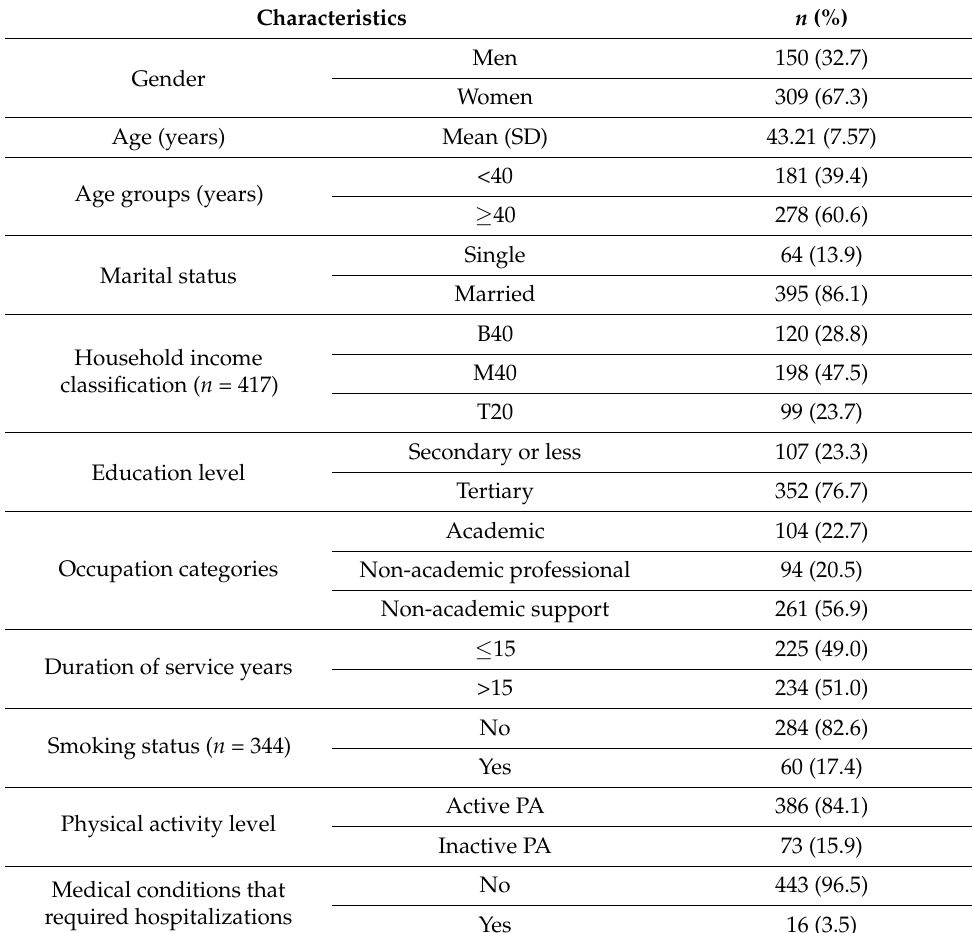
Table 1. Sample characteristics ( n =